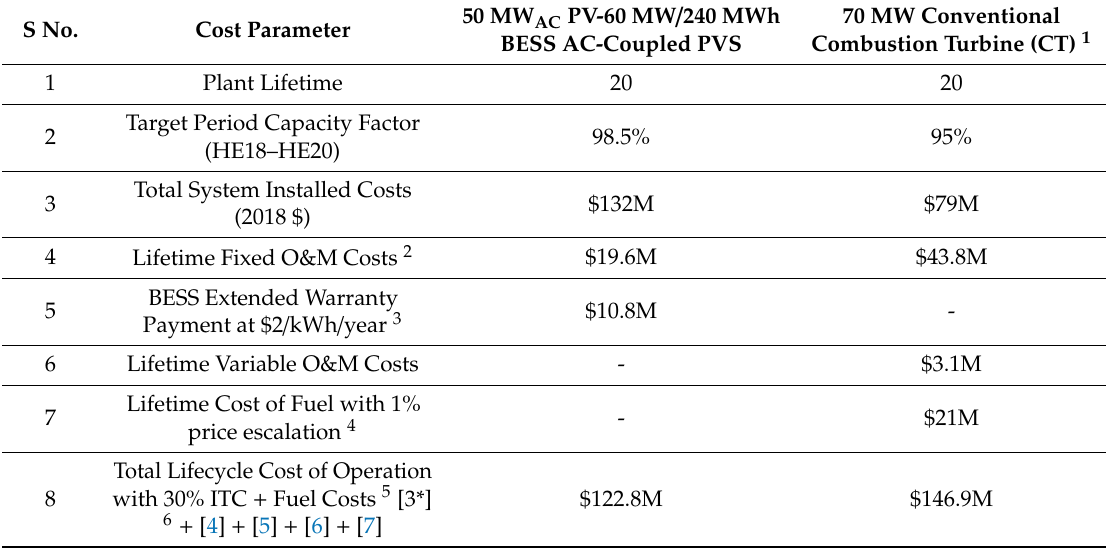
Table 5. Lifecycle Cost of Operation Comparison of the various non-baseload generation technologies for firm capacity provision in